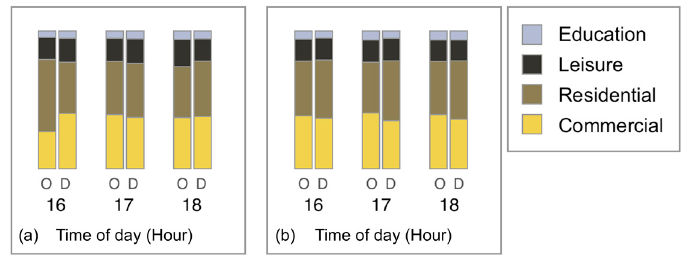
Figure 13. The proportions of origin and destination associated with di ff erent land uses during weekdays for ( a ) students in cluster 7 and ( b ) other students.